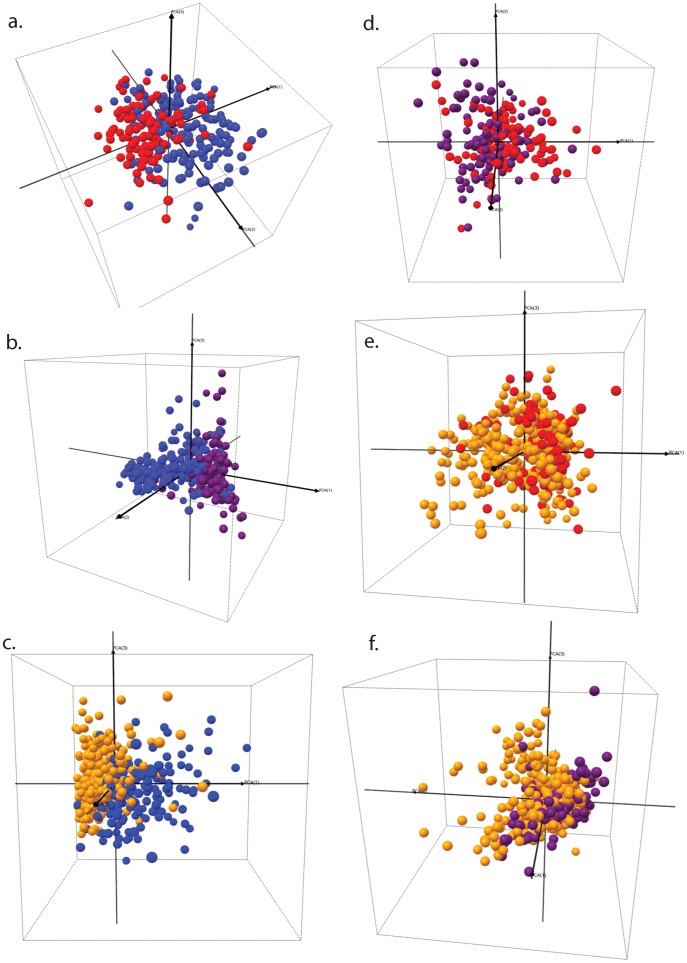
Visualization of (a-c) disease control (DC, non-parasitemic) children versus parasitemic children groups; (d-f) among CM, SMA and UM parasitaemic children groups.Each sphere represents an individual child proteome profile plotted in 3D space defined by the first three principal components. CM = Cerebral Malaria (red); SMA = Severe Malarial Anemia (purple); UM = Uncomplicated Malaria (yellow); DC = Disease Controls (blue). (a.) DC vs. CM; (b.) DC vs. SMA; (c.) DC vs. UM; (d.) CM vs. SMA; (e.) CM vs. UM and (f.) SMA vs. UM.